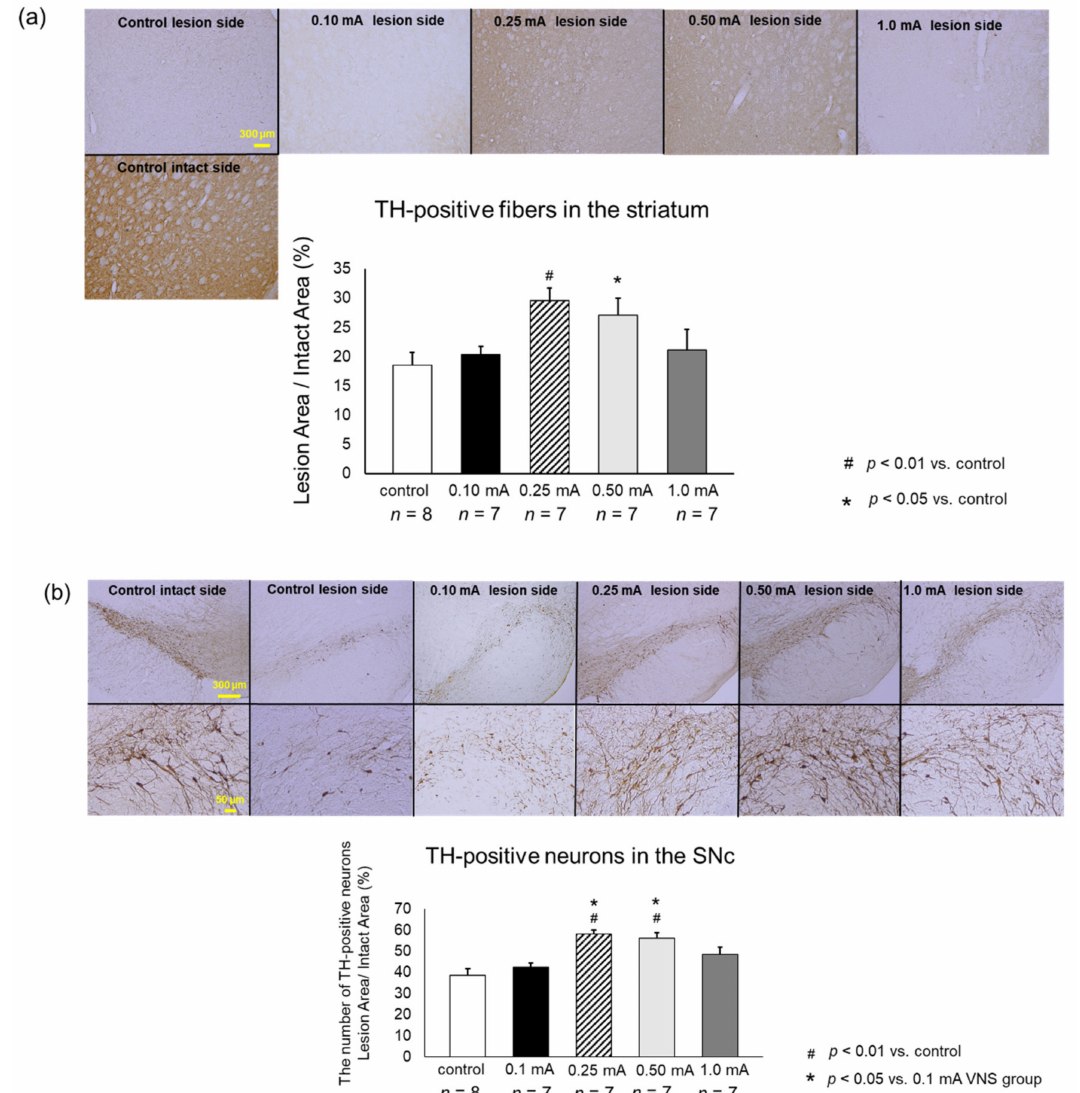
Figure 6. VNS with mild to moderate stimulation intensity preserved tyrosine hydroxylase (TH)-positive fibers in the striatum and TH-positive neurons in the SNc. ( a ) TH-positive fibers in the striatum. The ratio of TH-positive fibers in the lesioned striatum to the intact side was significantly preserved in the 0.25 mA and 0.5 mA VNS groups compared to that in the control group ( # p < 0.01 vs. control, * p < 0.05). ( b ) TH-positive neurons in the SNc.TH-positive neurons in the SNc in 0.25 mA and 0.5 mA VNS groups were significantly preserved compared to those in the control group and 0.1 mA VNS group ( # p < 0.01 vs. control, * p < 0.05 vs. control). The data are presented as means ± SE and analyzed by one-way ANOVA and Turkey’s post hoc tests. n = 7–8